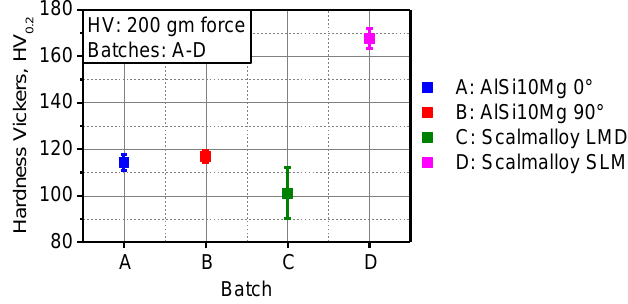
Figure 4. Microhardness measurements according to Vickers with 200 g-force of batches A–D.